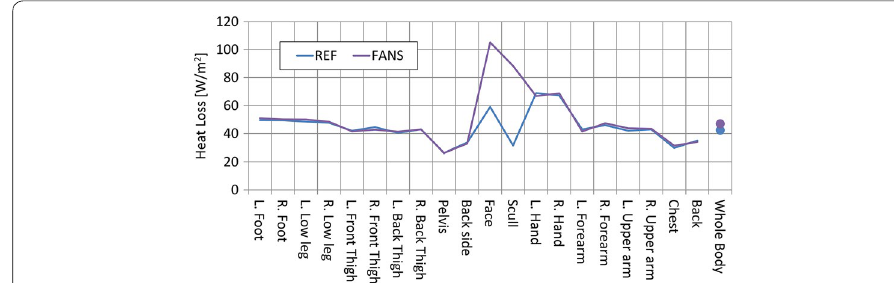
Fig. 6 Heat loss distribution among segments of FANS